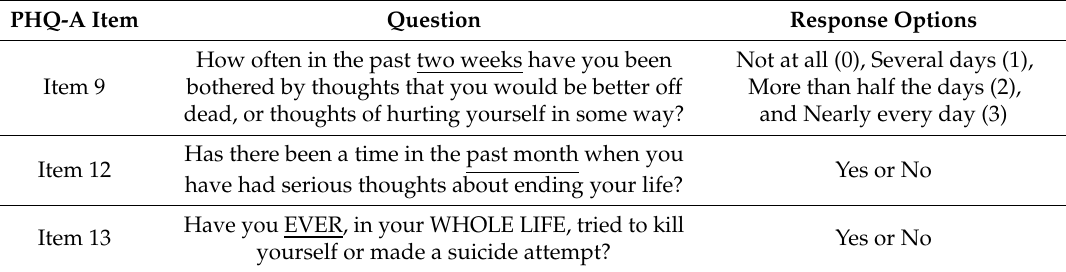
Table 2. Suicide-related items on the Patient Health Questionnaire 9-Item Modified for